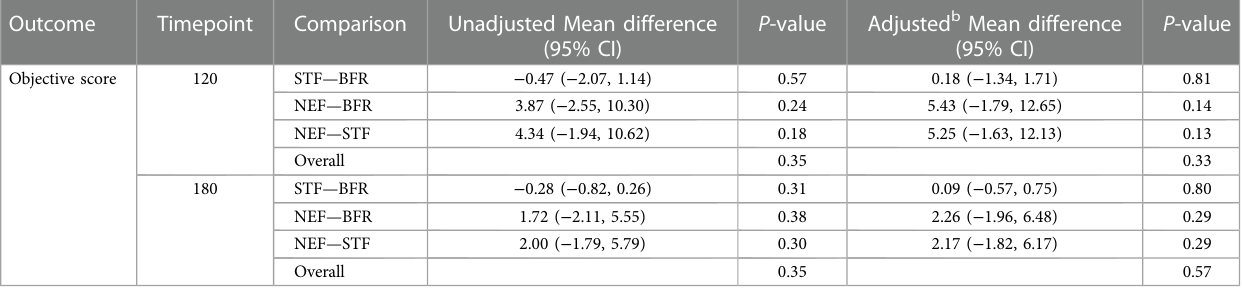
TABLE 7 SCORAD a assessment all groups.